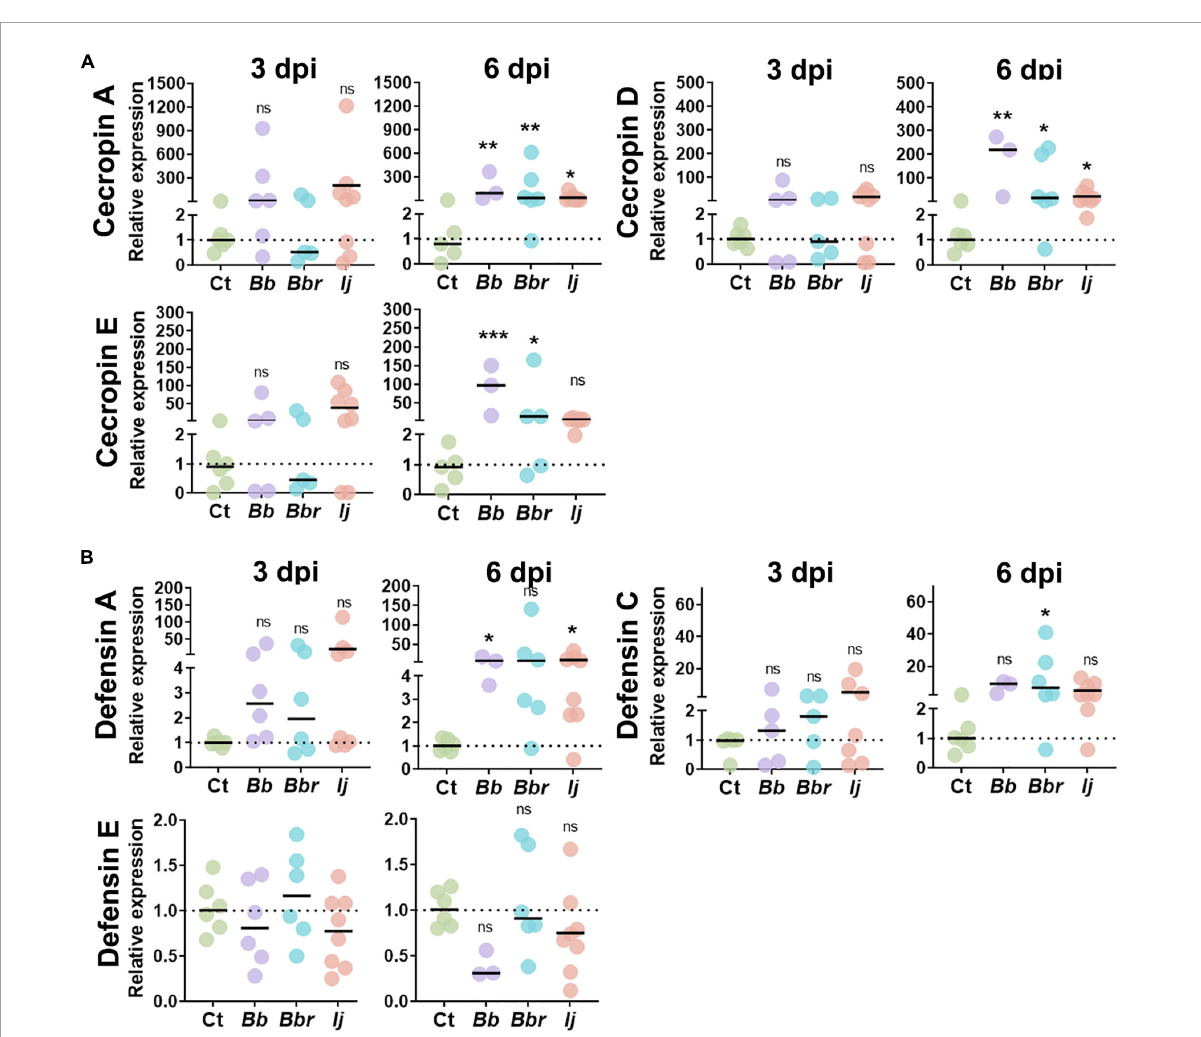
FIGURE1 Induction of Ae. aegypti AMPs following infection with entomopathogenic fungi. Relative gene expression profiles of CecA, CecD, and CecE (A) , and defensin A, defensin C, and defensin E (B) in mosquitos infected with B. bassiana , B. brongniartii , and I. javanica at 3 and 6 dpi. The horizontal bar indicates the median level of expression from two independent experiments and each dot represents a pool of five mosquitoes. The statistical significance of relative gene expression was determined on log2-transformed values via ANOVA with Dunn’s multiple comparison test. * P < 0.05, ** P < 0.01, and *** P <